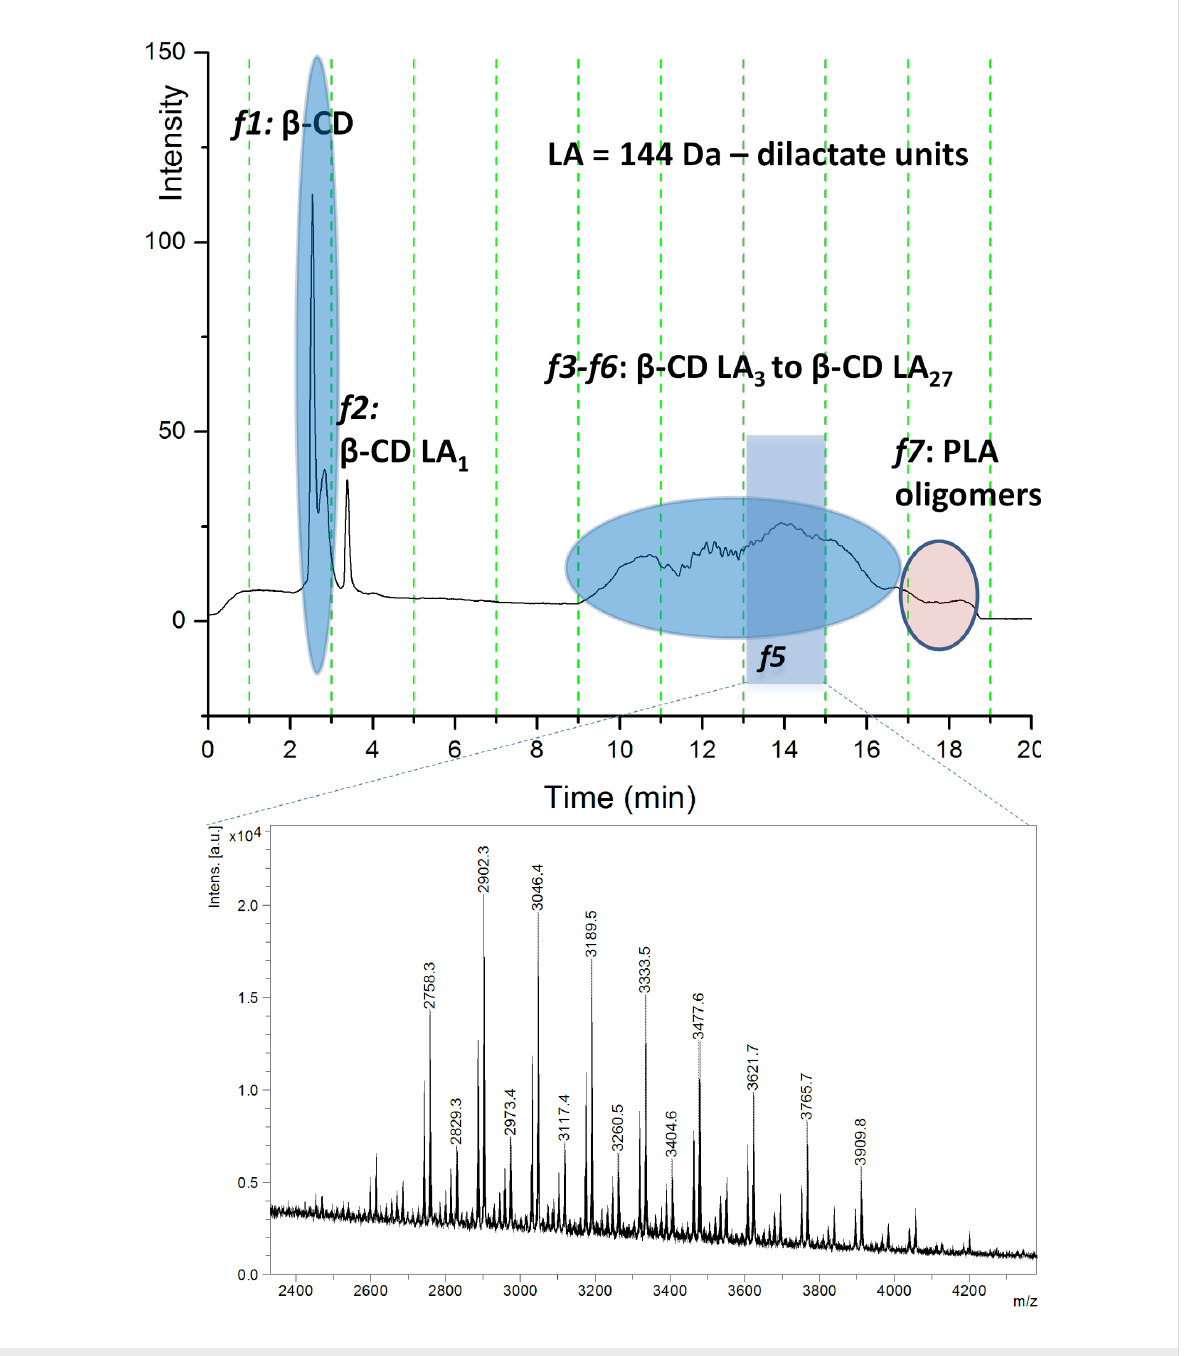
Figure 1: (a) ELSD chromatogram of crude β -CD-LA reaction mixture and (b) MALDI–MS spectrum of fraction f 5.